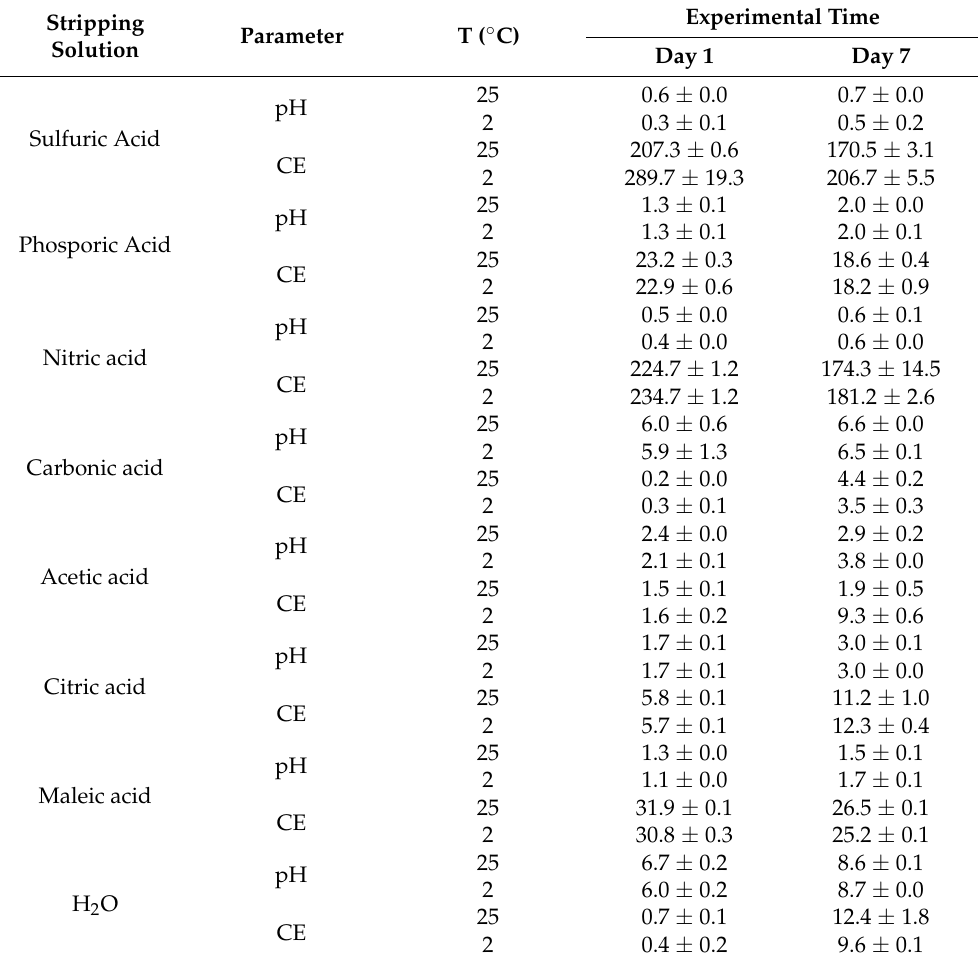
Table 1. pH and EC values at the beginning and the end of the experiment for the different NH 3 trapping solutions at two temperatures, 25 and 2 ◦ C, representative of the winter and summer scenarios,